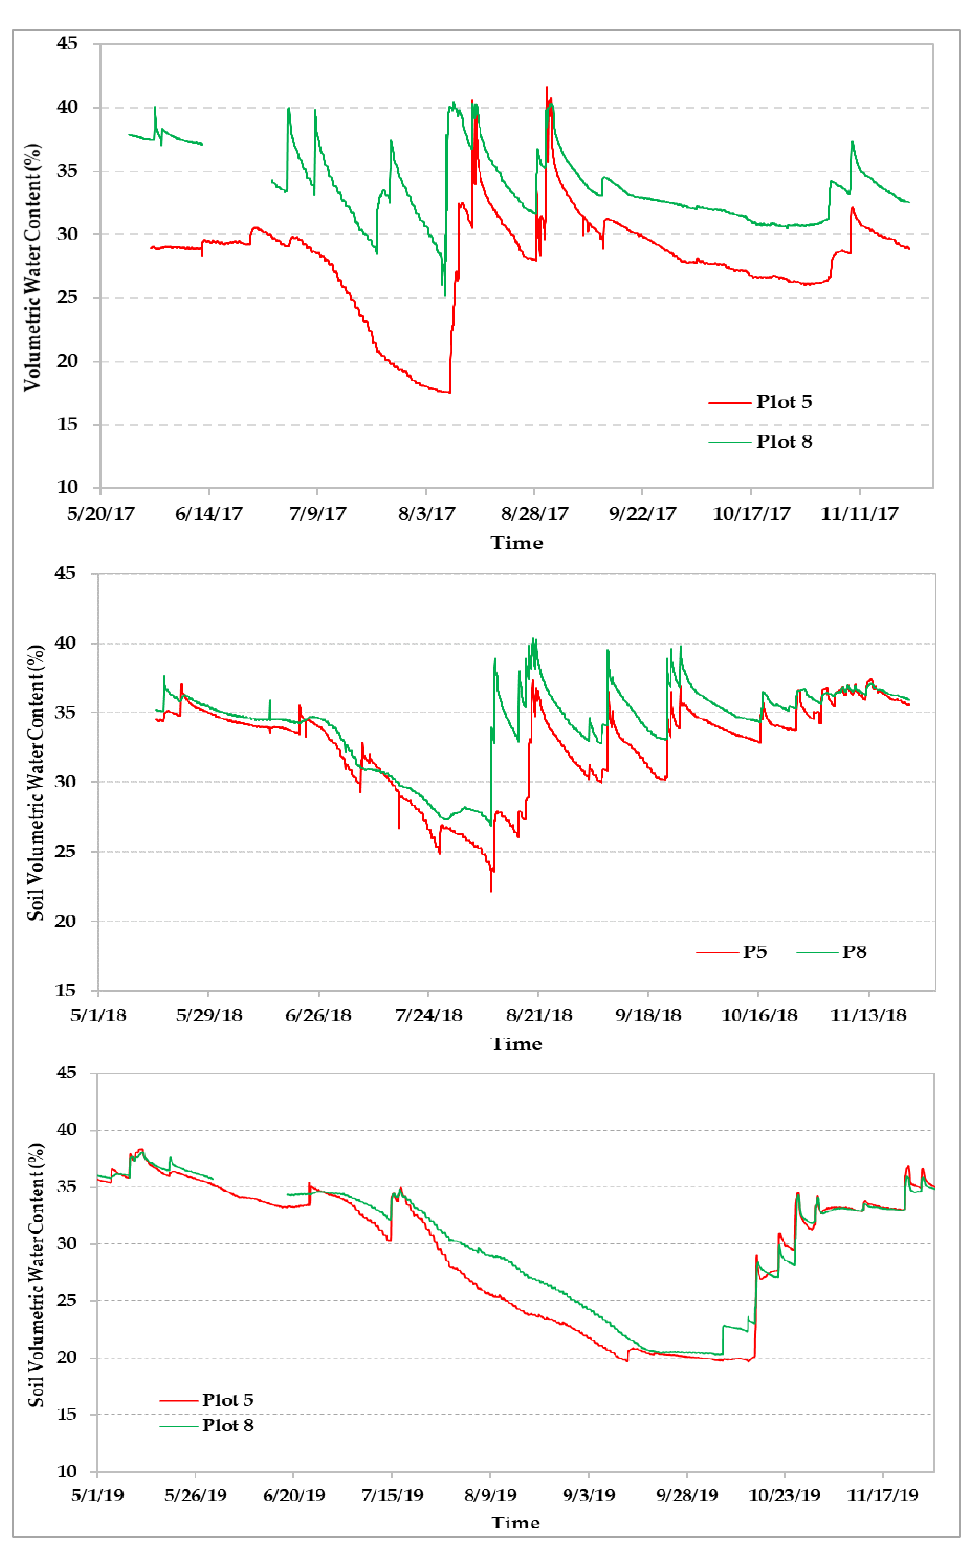
Figure 4. Soil water content variation in Plot 5 and Plot 8 during cotton growth season in 2017 – 2019. Plot 5 had no cover crop while Plot 8 had cover crop. Both plots had the same nitrogen application rate of 140 kg ha −1 .